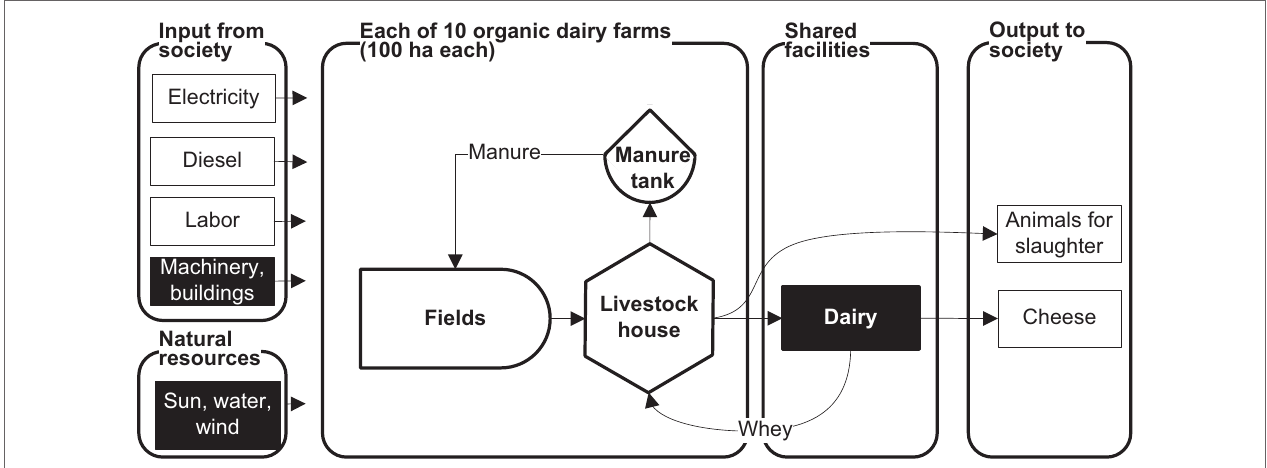
FigUre 1 | Material and energy flows in the reference scenario . The system consists of 10 identical farms and a shared dairy. Based on the natural resources and input from the society, each farm produces fodder for the livestock. The cows produce manure, animals for slaughter and milk for the dairy. The dairy then produces cheese and whey that are fed back to the cows as fodder. The manure is used as fertilizers on the fields. The dairy is included as a black box because energy and labor use in this process is not accounted for, neither is indirect energy use for the production of machinery and buildings. For further explanation, see text (see The Reference